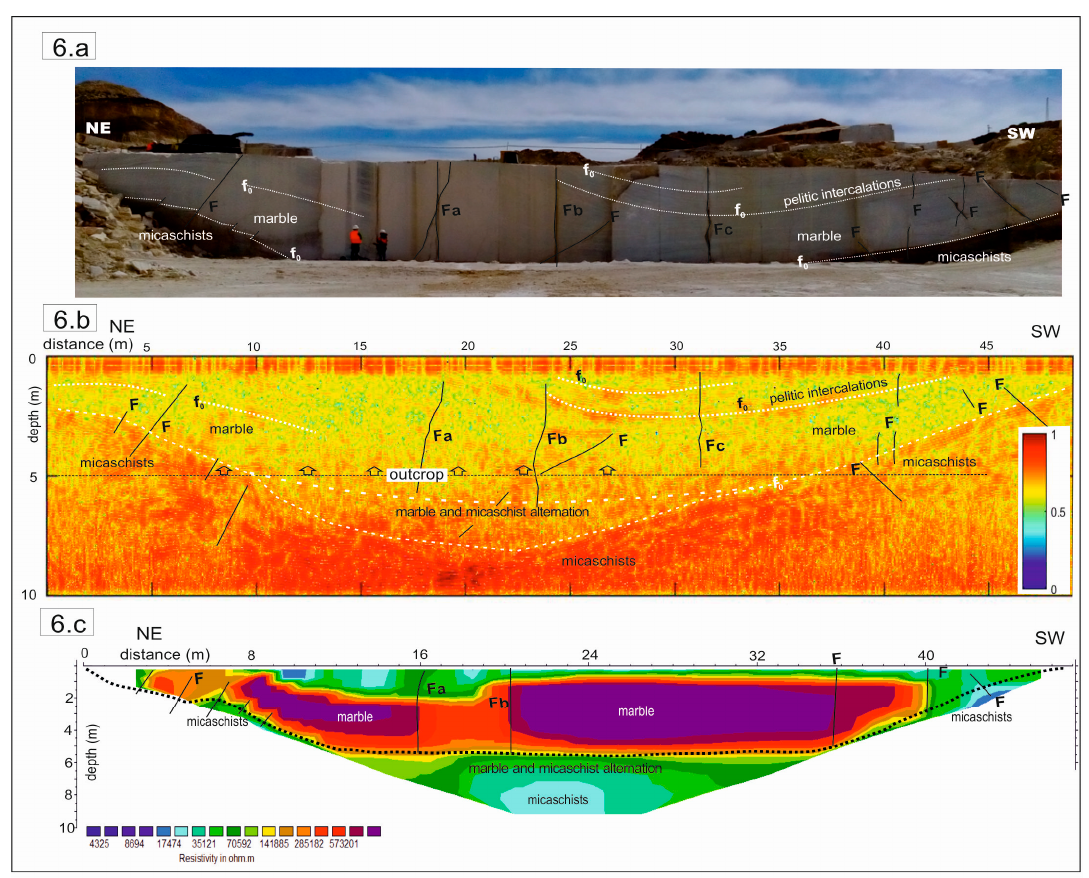
Figure 6. Overview of the front of the marble mining bank. Stratification(f 0 ) (defined by the presence of pelitic intercalations) and observed fractures (F) are outlined on the outcrop. Some of these fractures are correlated with Figure 6a,b and Figure 7a–c. ( a ) Radargram of the bank corresponding to profile P01. The amplitude scale is plotted in a logarithmic scale ( b ) Interpretation of the ERI profile of real resistivity sections.